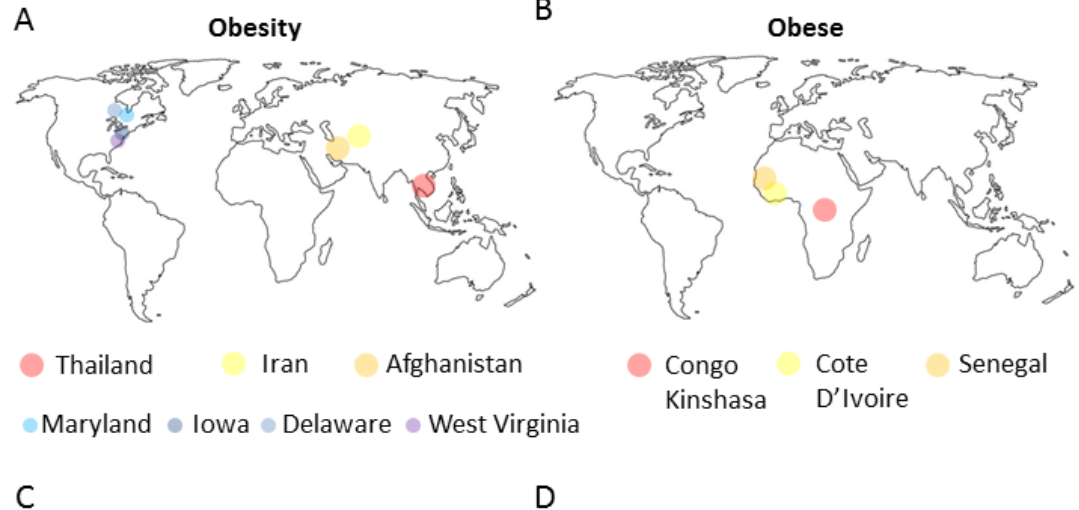
Figure 2. Worldwide distribution of the obesity-related search terms and topics and the top 3 countries with the highest search volume during the study